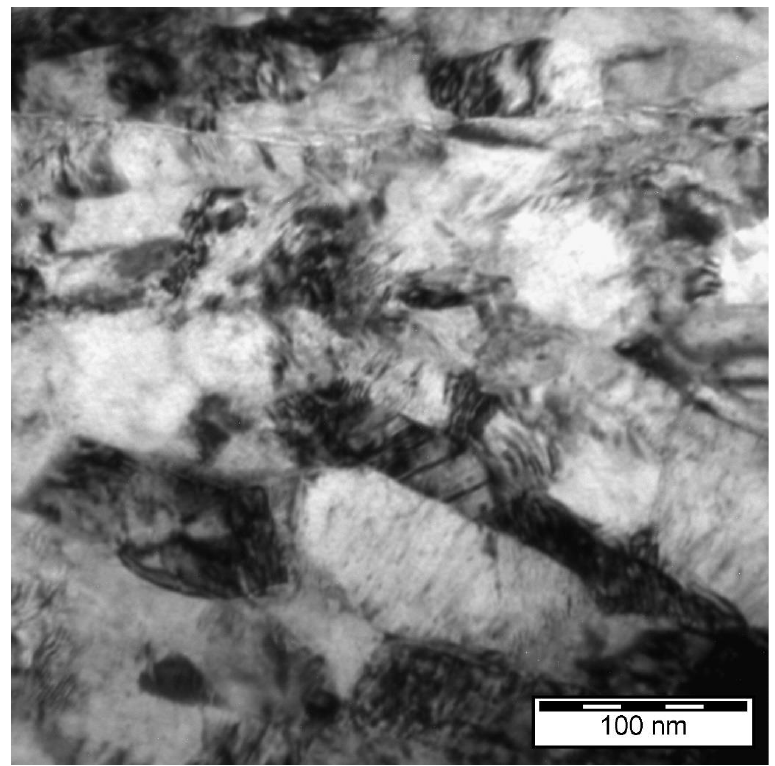
Figure 6. TEM microstructure of the coatings. Figure 6 reveals a very fine microstructure with the main grains axes all oriented in a direction perpendicular to the spray direction. The microstructure observed in Figure 6 terials during processing.